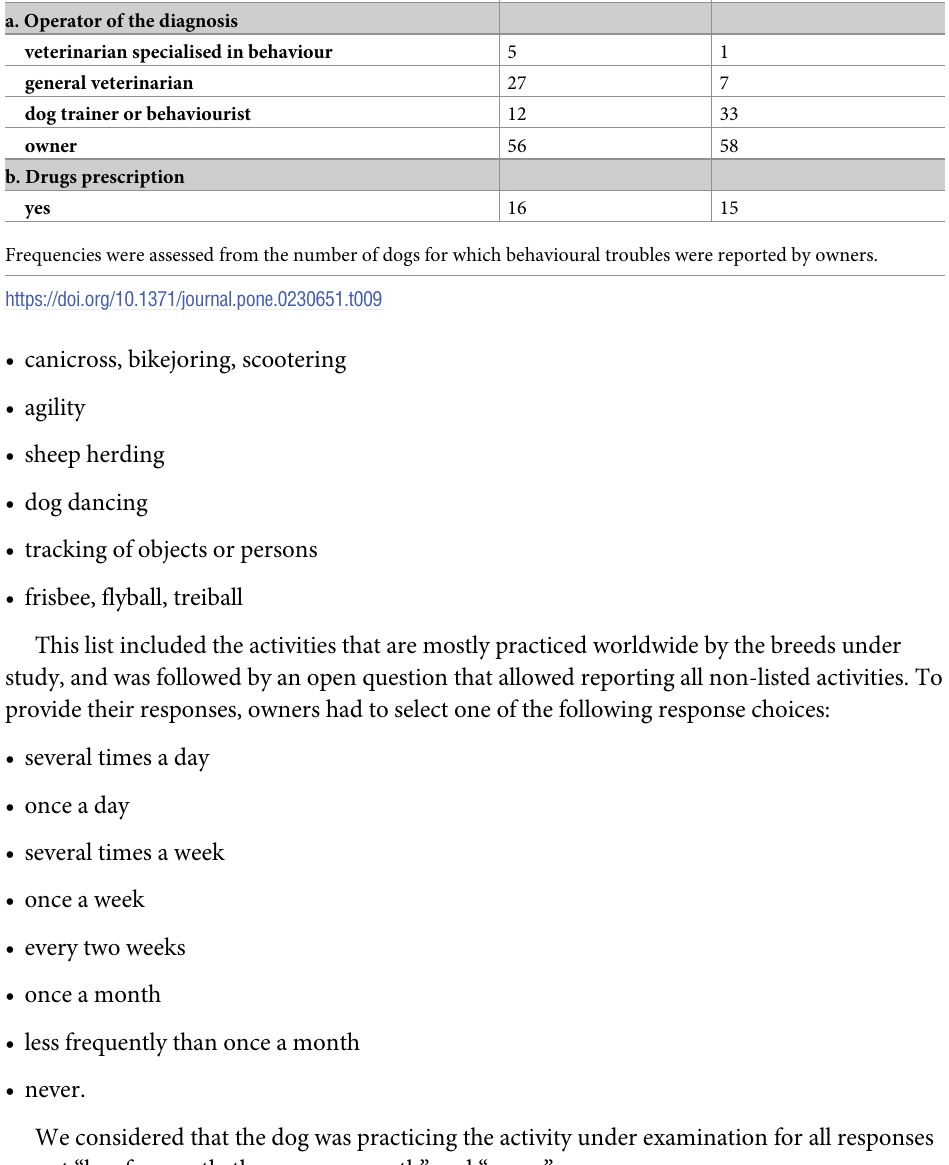
Table 9. Frequencies of responses, in percentage, obtained for IMP and HNVN dogs concerning behavioural trou- bles: (a) operator of the diagnosis and (b) drugs prescription. IMP HNVN